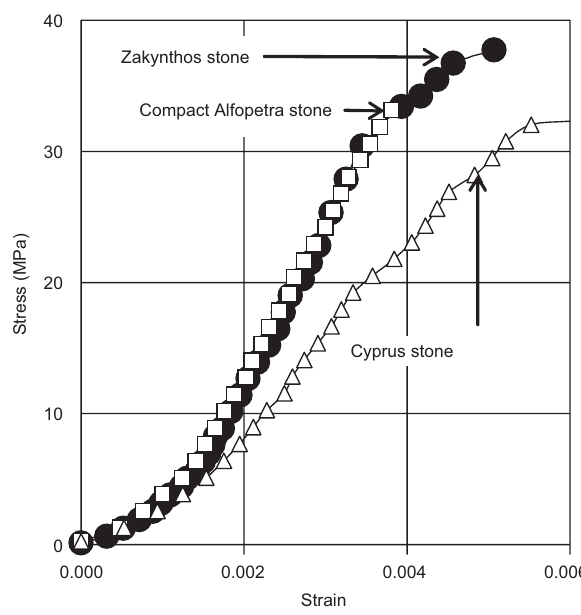
Figure 12 Axial stress vs. axial strain (up to the peak load) under compression of the building stones considered as possible substitutes of the authentic Kenchreae stone.